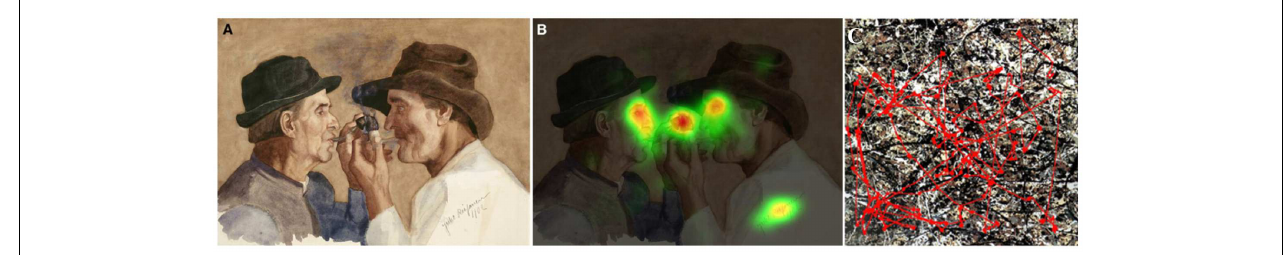
FIGURE 2 | Differences in eye scanning patterns of a figurative versus abstract painting. (A) Figurative painting, “Piipunsytyttäjät/Lighting pipes” by Rissanen (1902). (B) . Eye tracking distribution of 20 individuals on this painting. Note the focal distribution of the fixation points that concentrates primarily on the faces, the pipe and the artist’s signature (replicated from Hari and Kujala, 2009). (C) Fixation (red lines) distribution on an abstract painting by Jackson Pollock. Note the broad trajectories of the eye tracking movements in the case of abstract art (replicated from Taylor et al.,